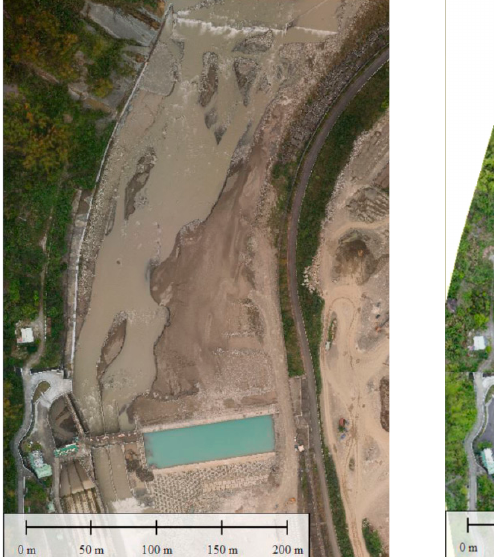
Figure 6. SenseFly Ebee+ was used in this study. The picture taken before the flight mission on 10 April 2017.